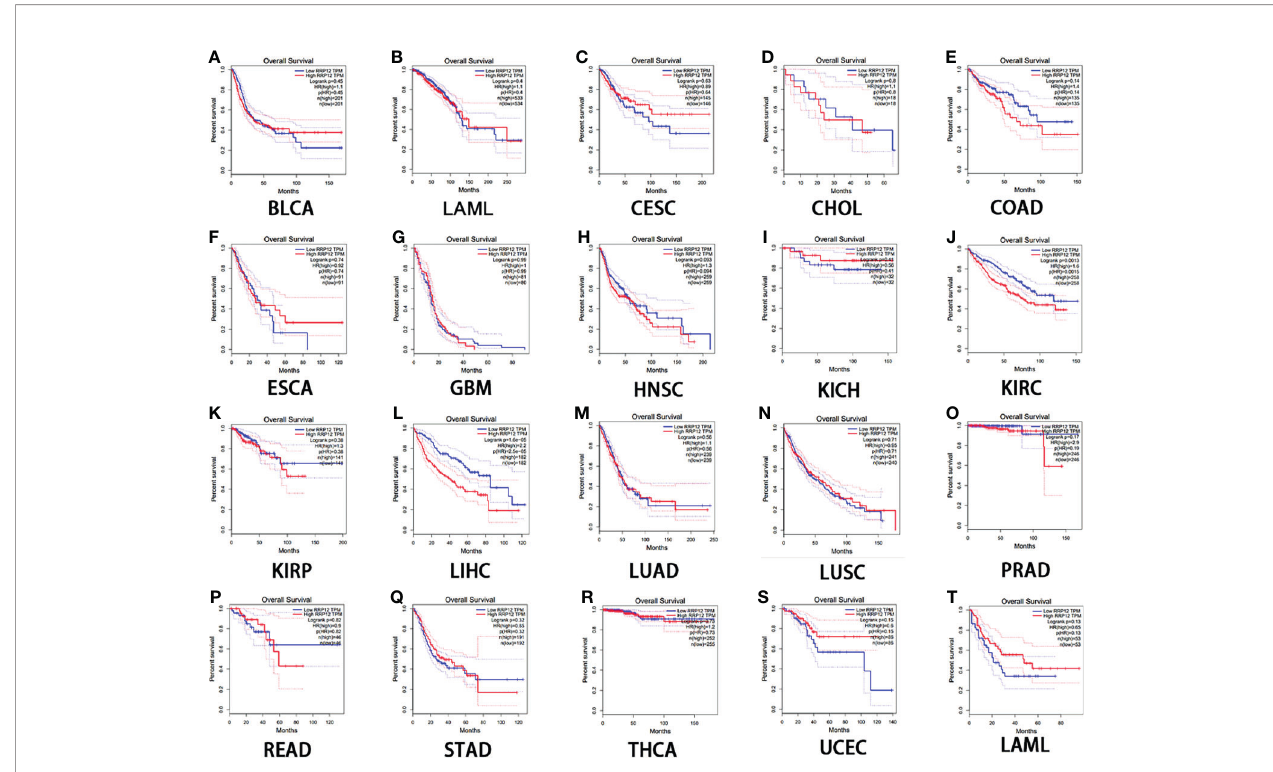
FIGURE 2 | The overall survival (OS) analysis for RRP12 in various human cancers determined by GEPIA database. (A – T) The OS plot of RRP12 in BLCA (A) , BRCA (B) , CESC (C) , CHOL (D) , COAD (E) , ESCA (F) , GBM (G) , HNSC (H) , KICH (I) , KIRP (J) , KIRC (K) , LIHC (L) , LUAD (M) , LUSC (N) , PRAD (O) , READ (P) , STAD (Q) , THCA (R) , UCEC (S) and LAML (T) . p<0.05 is statistically signi fi